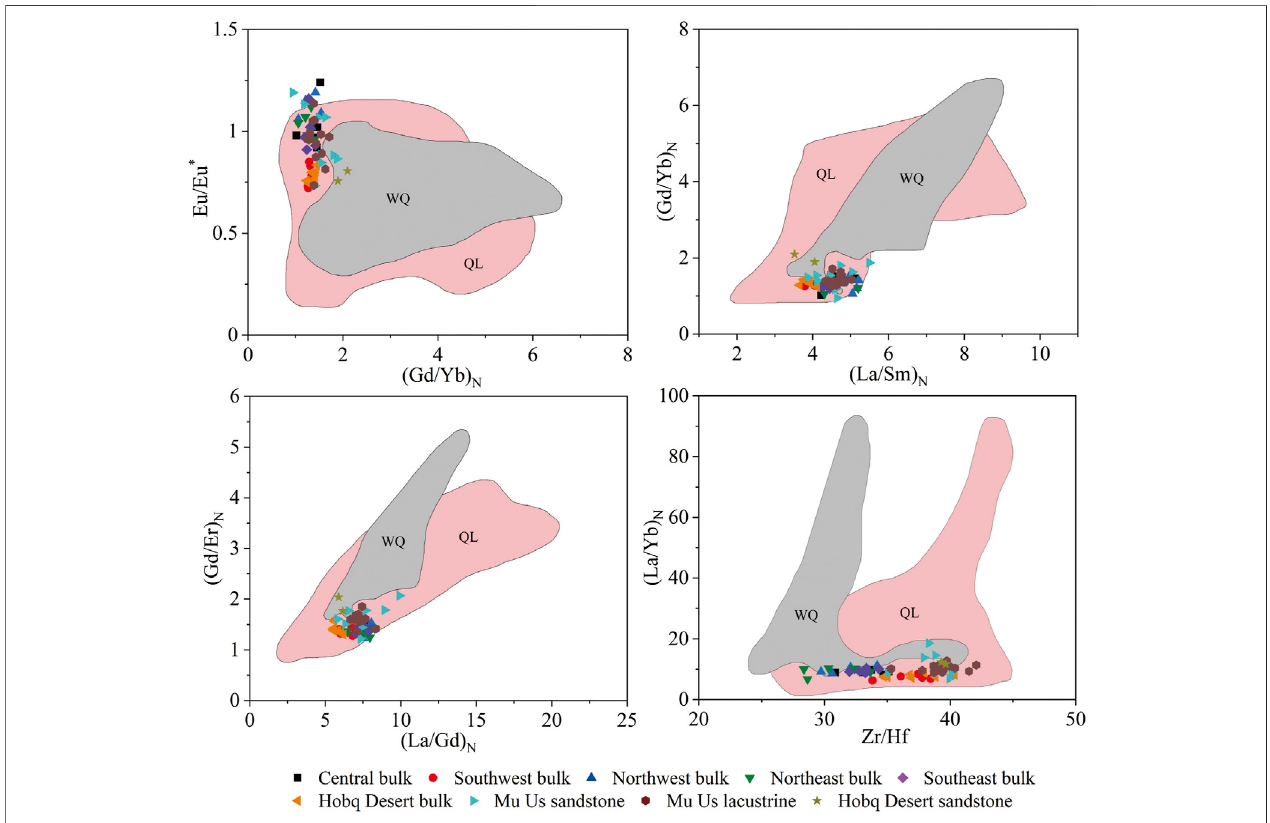
FIGURE13 | Bivariate diagrams ofgeochemical elements ratios ofsamplesbetweenthe Ordos Deserts and their potential source areas.Data from other potential sourceareasincludingthosefromtheQilianOrogenicBelt(Wuetal.,2010;Tungetal.,2013;LiJ.etal.,2017),thewesternQinlingOrogenicBelt(Zhangetal.,2007;Xin, 2014). Data of sandstone and lacustrine sediments in Mu Us and the Hobq Desert is from Liu and Yang (2018). Abbreviations: QL, the Qilian Orogenic Belt; WQ, the western Qinling Orogenic Belt.